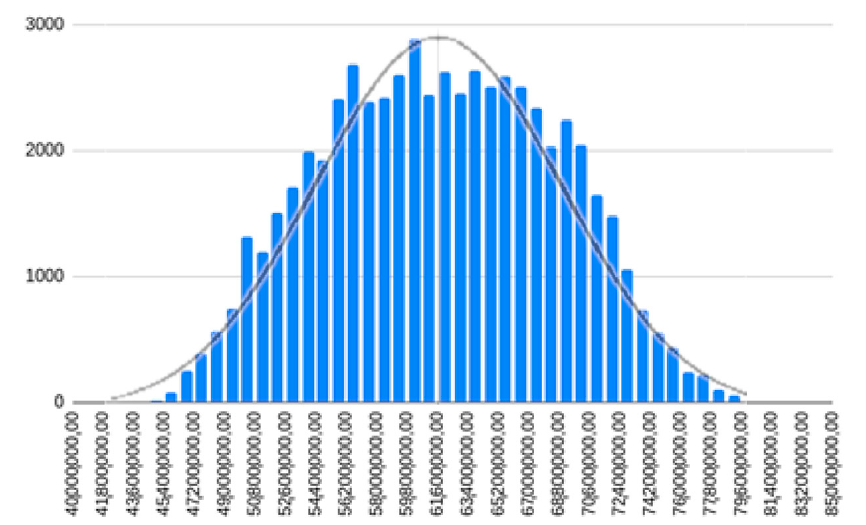
Figure 2. Profit distribution of simulation solutions.